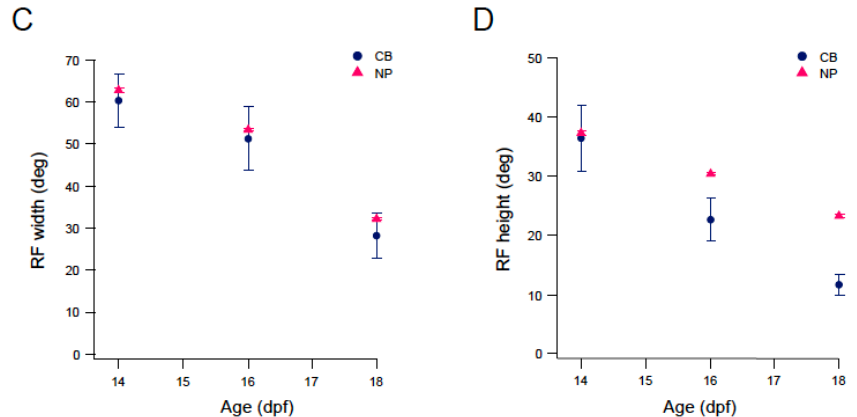
Figure 4. Spatial receptive field sizes in the optic tectum of 14, 16, and 18 dpf larvae ( A , B ) Distribution of RF width ( A ) and height ( B ) in the neuropil (magenta) and PVN cell bodies (blue). RF size was determined by parametric fitting of a bivariate Gaussian distribution and defined as 4 σ . ( C ) Average spatial RF width at 14, 16, and 18 dpf. ( D ) Average spatial RF height at 14, 16, and 18 dpf. (NP: n = 7790 voxels from 6 fish; CB: n = 48 cells from 5 fish).